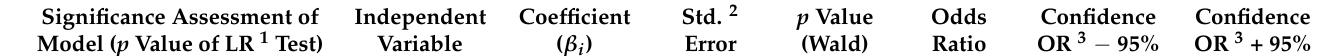
Table 2. Results logistic regression models. Passive surveillance model (road-killed).